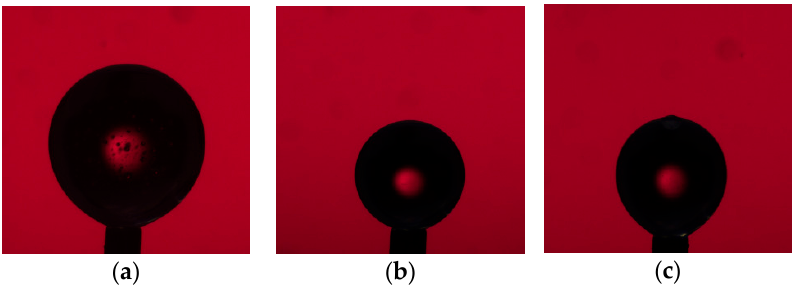
Figure 2. Examples of typical droplet images taken for interfacial calculation by axisymmetric drop shape analysis (ADSA): ( a ) 15 μ L neat triolein, 𝑁𝑒 = 0.8 ; ( b ) 5 μ L neat triolein, 𝑁𝑒 = 0.5 ; ( c ) 5 μ L triolein coated in POPC and full-length perilipin 3, 𝑁𝑒 = 0.7 . Table 1. Examples of triolein droplet surface tension values as reported by ADSA.